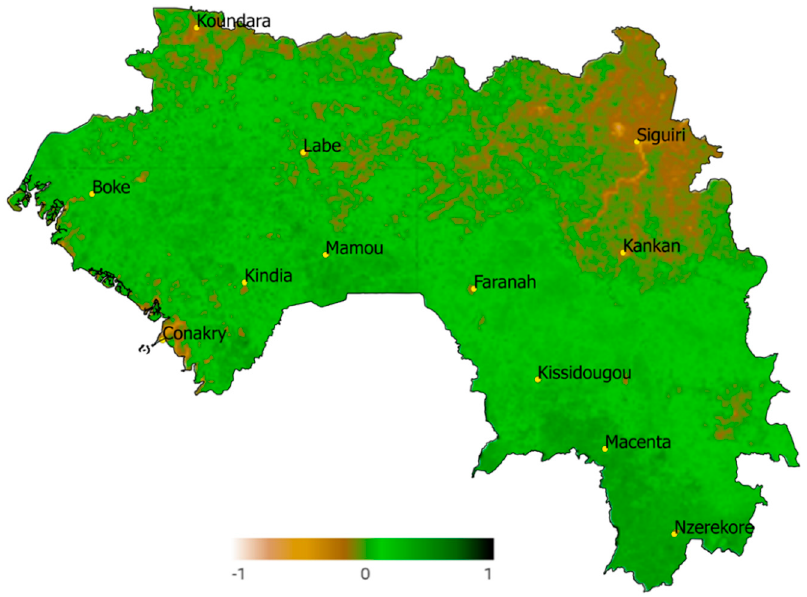
Figure 11. The averaged normalized difference vegetation index (NDVI) from 2002 to 2016 over Guinea.